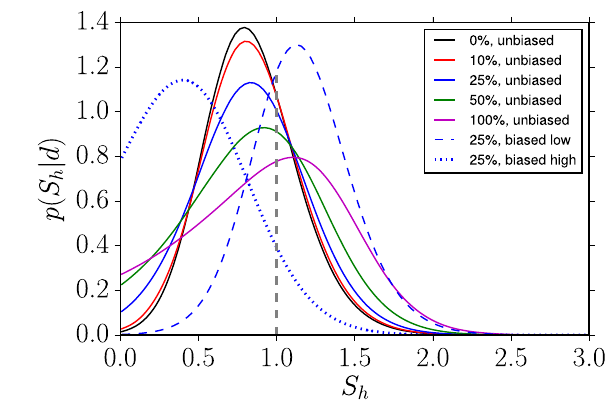
Fig. 20 Posterior distributions for S h for the null channel analysis, corresponding to different priors for the parameter a , which relates the instrumental noise variances in the two channels. The labels “ p %, unbiased” correspondto A = a 0 and Σ = 1 + p / 100;thelabels“25%,biasedlow(orhigh)”correspondto A = 0 . 67 a 0 (or 1 . 5 a 0 ) and Σ = 1 . 25. The vertical grey dashed line corresponds to the injected value of S